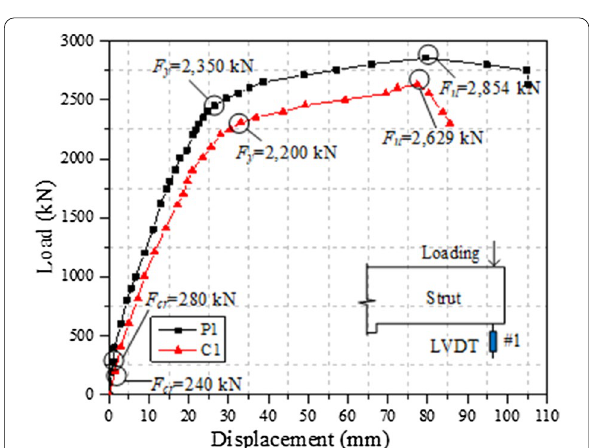
Fig. 13 Displacement–load curve for the monotonic